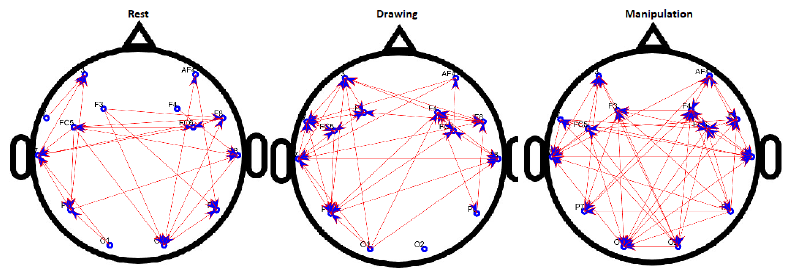
Figure 8. Binary directed functional brain network during rest, drawing and manipulation states of novice user.